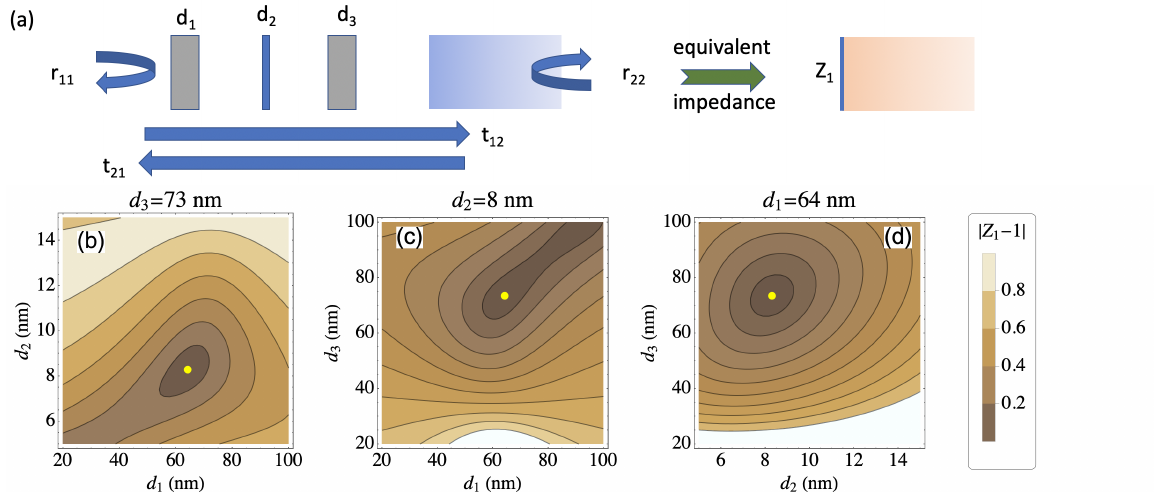
Figure 1. ( a ) Schematic representation of the structure consisting of three layers (silica, metal, silica) with respective thicknesses ( d 1 , d 2 and d 3 ) on top of the thick metal layer. The field coefficients are defined in the text. ( b – d ) impedance mismatch | Z 1 − 1 | as a function of the different layer thicknesses for normal incidence at a wavelength ( λ = 500 nm). The yellow dot corresponds to the layer thicknesses ( d 1 = 64 nm, d 2 = 8 nm, d 3 = 73 nm) minimizing overall back-reflection r 11 .